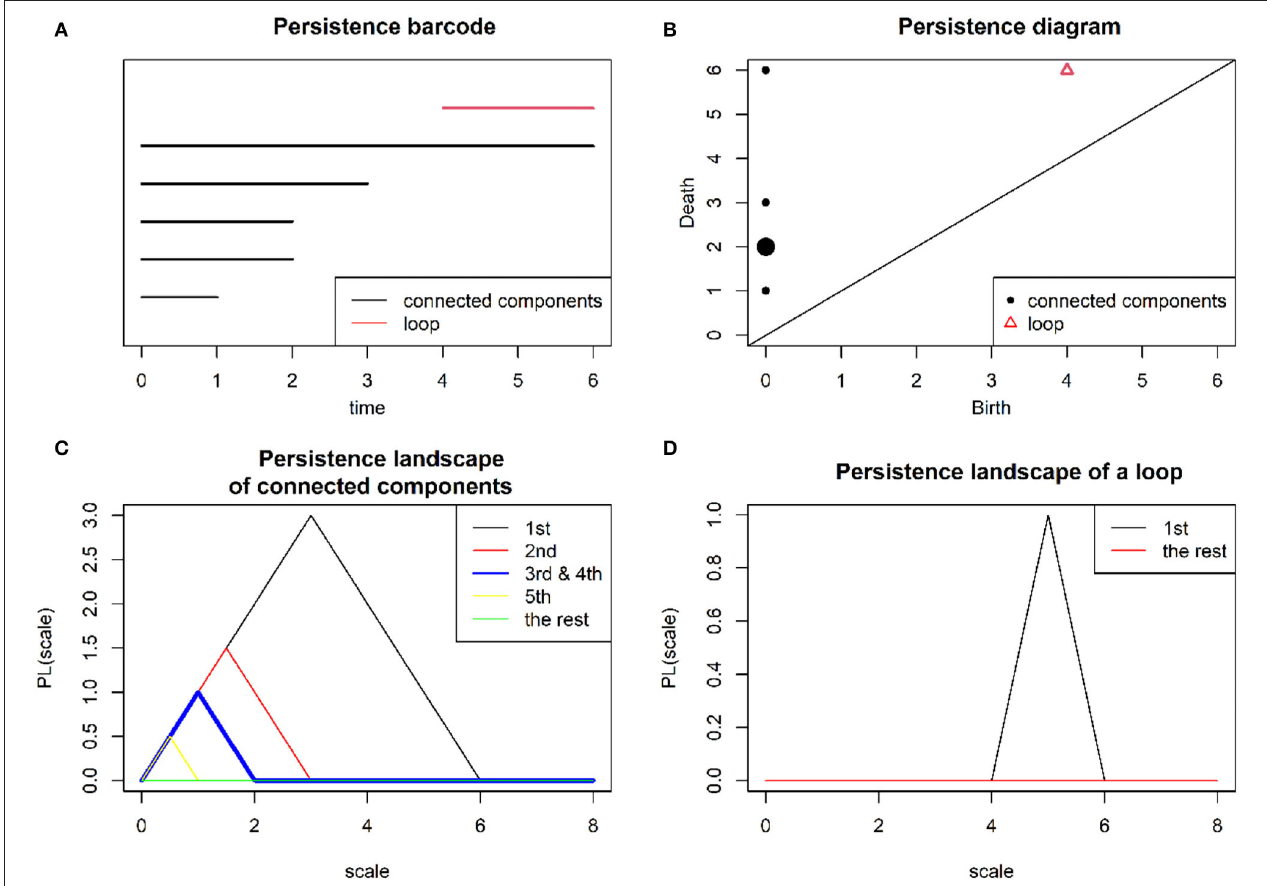
FIGURE 3 | Refer to the filtration of Rips complexes in Figure 2 . By applying PH, compact representations: (A) a persistent barcode, (B) a persistence diagram (note that the size for point (0, 2) is enlarged two times bigger than the others to indicate two connected components that share a redundant lifetime), (C) a persistence landscape of connected components (note that the third sub-landscape is enlarged two times bigger than the others to indicate two connected components, which share a redundant lifetime), and (D) a persistence landscape of a loop are